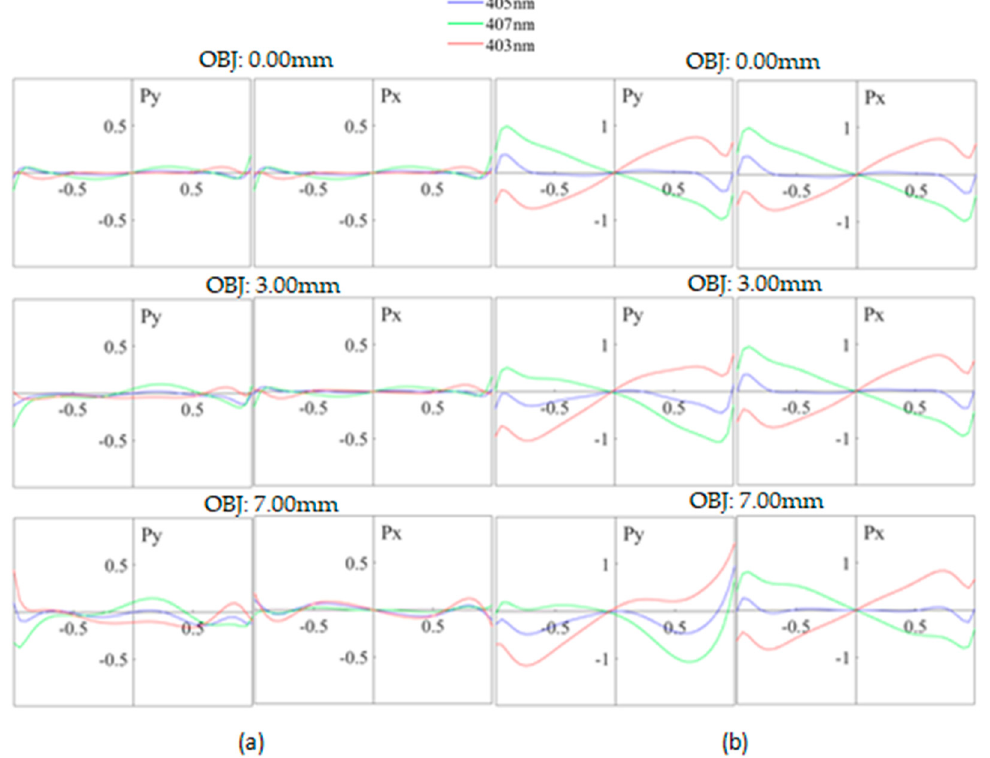
Figure 7. Wave aberrations of different fields of view for hybrid ( a ) and traditional ( b ) projection lens systems.